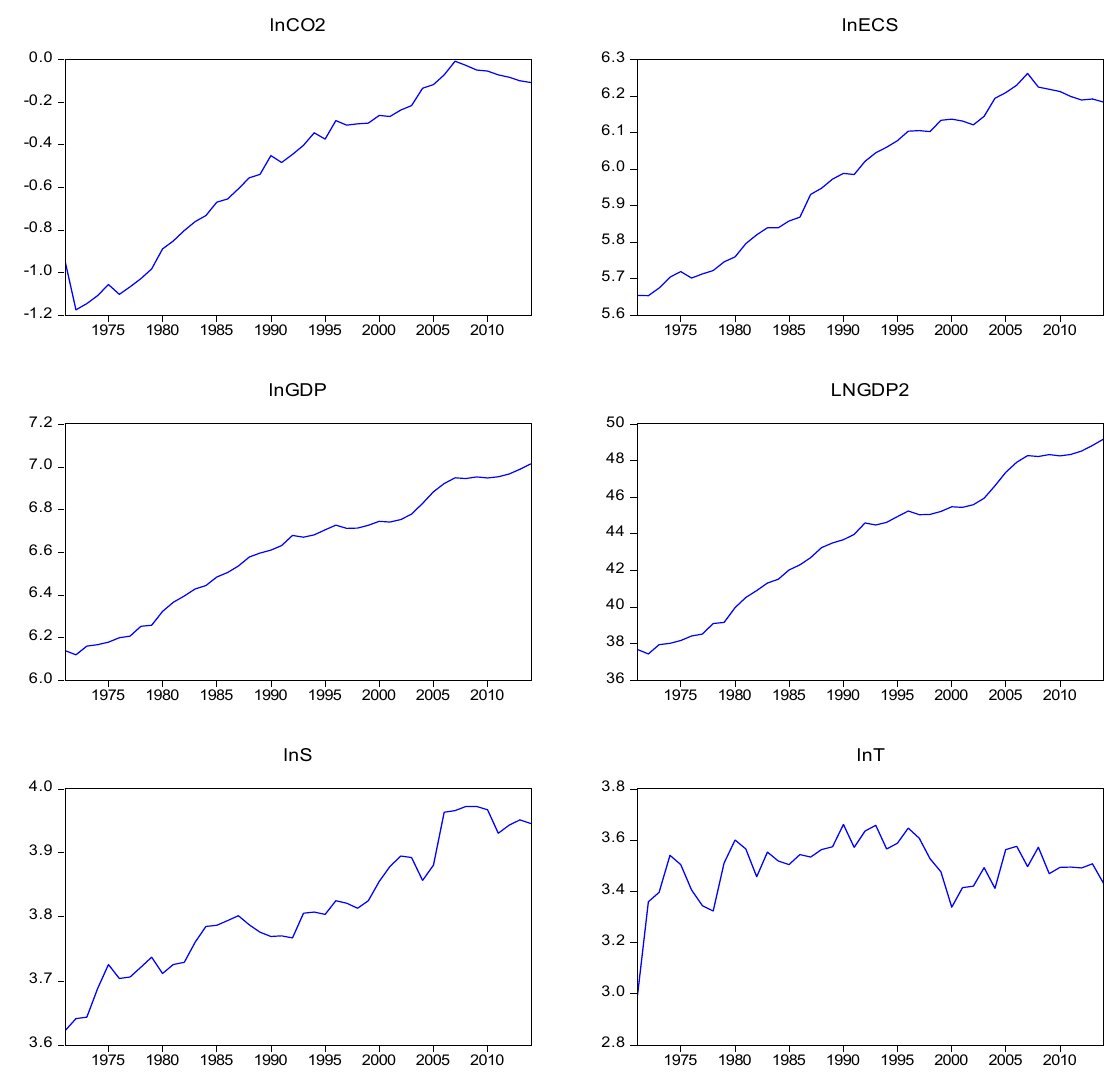
Figure A1. Time trends of variables over 1971–2014.